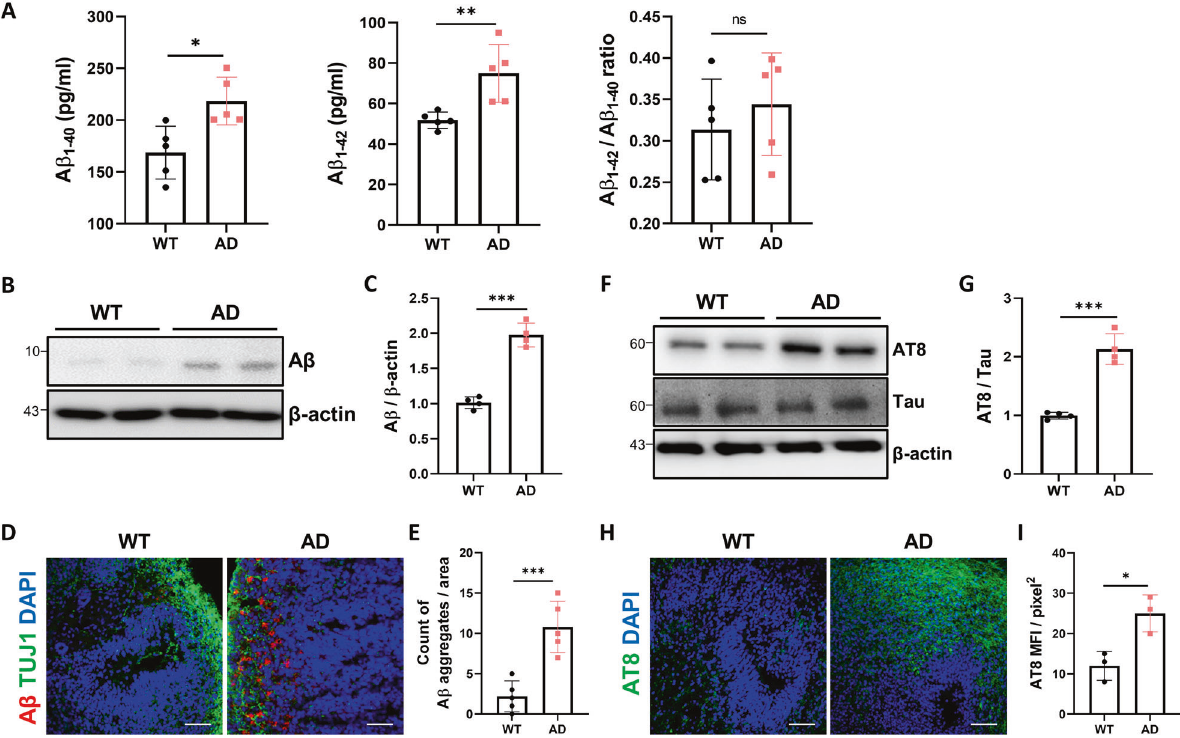
Fig. 2 AD brain organoids exhibit AD-like phenotypes at day 60. A Lysates of WT organoids and AD organoids were analyzed by ELISA at day 60. The amounts of A β 1-40 and A β 1-42 in the RIPA fraction were measured by ELISA ( n = 5). B , C Amounts of beta-amyloid were assessed by western blotting analysis in WT and AD organoids at day 60 ( n = 4). D Representative images of the immunostaining for A β and TUJ1 in WT and AD organoids at day 60. E Quanti fi cation of A β immunoreactivity and particle counts in WT and AD organoids ( n = 5). Scale bars, 50 µm. A β levels detected by D54D2 antibody. F , G Total tau and p-tau levels of WT and AD organoids were analyzed by western blotting and quanti fi ed. H , I Representative images of immunostaining for p-Tau in WT and AD organoids at day 60 ( n = 3). The p-tau levels detected by AT8 (Ser202/Thr205) antibody ( n = 3). Scale bars, 50 µm. n.s.: not signi fi cant, * P < 0.05, ** P < 0.01, and *** P < 0.001. The data are presented as the mean ±